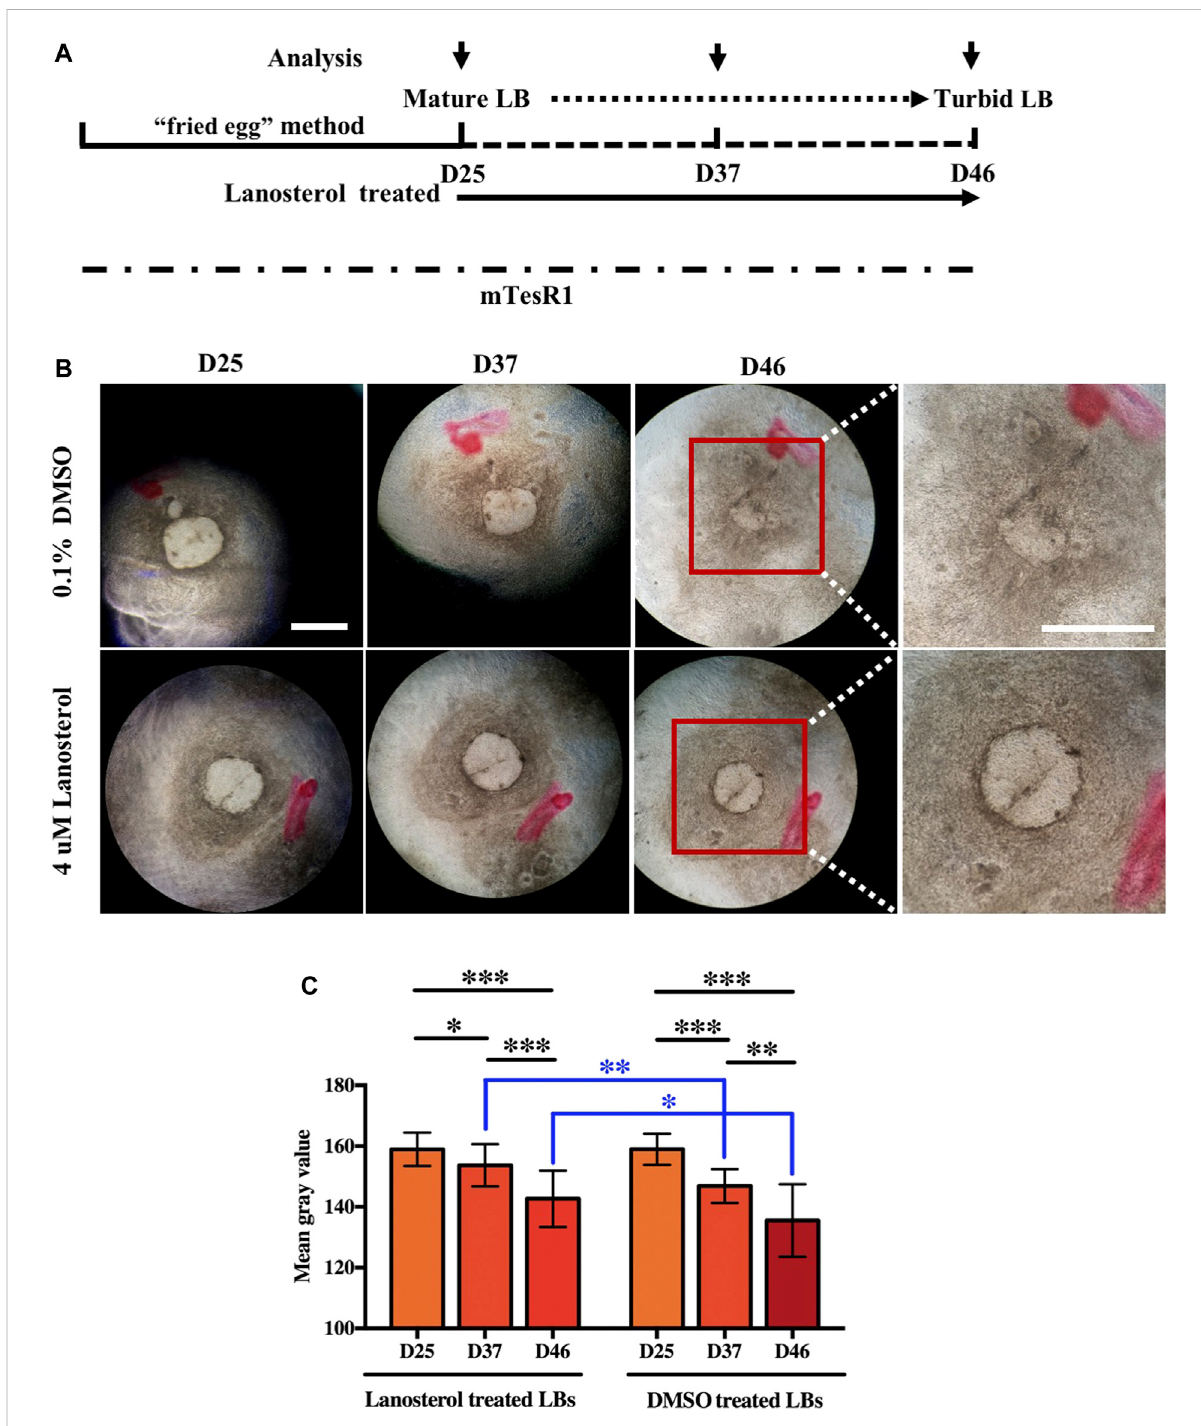
FIGURE 1 Lanosterol alleviates the opacity of LBs with extended culture time. (A) The schematic diagram of LB generation and lanosterol treatment. (B) Clouding in the LBs with longer incubation was alleviated after lanosterol treatment. Representative pictures of LBs on D25, D37, and D46 were shown. (C) The opacity degrees of LBs were evaluated by mean gray value using the ImageJ software. At least 15 LBs in each group from three independentexperimentswereexamined.Barsrepresentmean±SD.* p < .05,** p < .01,*** p < .001.Scalebar:1